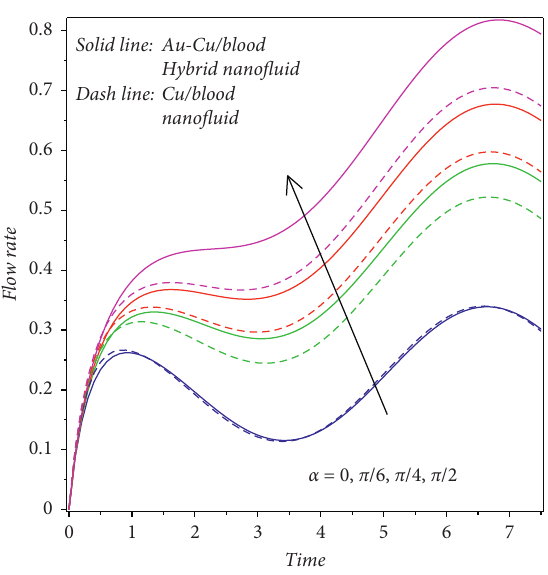
Figure 15: Behaviour of R